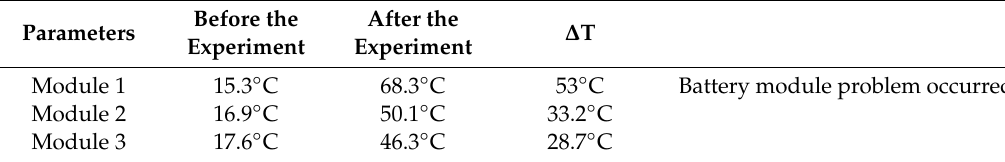
Table 3. The temperature profile of battery module with fault diagnosis algorithm.